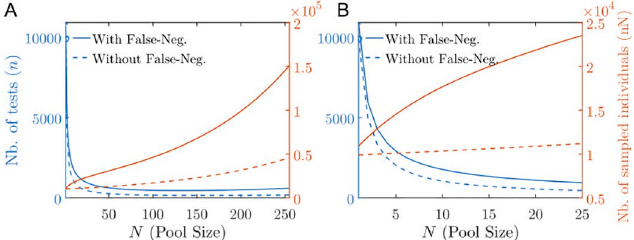
Fig 6. (A,B) Total number of tests (red) and total number of sampled individuals (blue) in order to estimate a prevalence of p = 1% with a ± 0.2% precision with 95% confidence interval as a function of the pool size N for the perfect case (dashed lines) with no false negative versus the case with false negatives (solid lines) estimated according to the Lennon et al. asymptomatic dataset [55]. In (A) N ranges from 0 to 25; in (B) N ranges from 0 to 128. The optimal pool size N ð perf Þ is beyond the N -axis opt